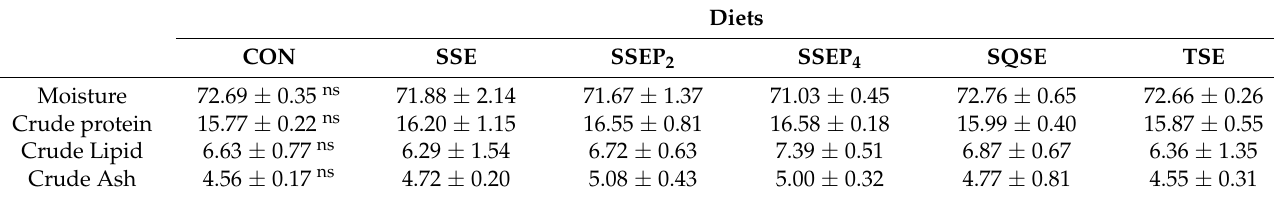
Table 3. Whole body proximate composition of Nile tilapia fed six experimental diets for eight weeks (% dry matter basis) 1 .